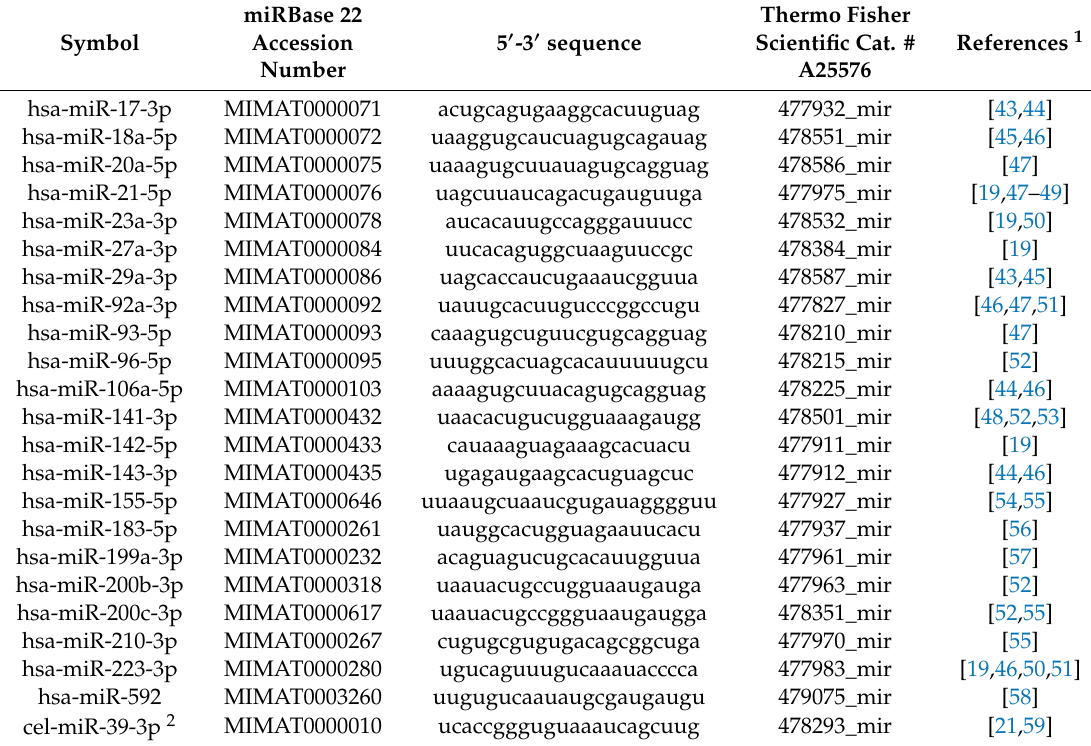
Table 4. The analyzed microRNAs with miRBase 22 accession numbers, sequences, catalogue numbers, and